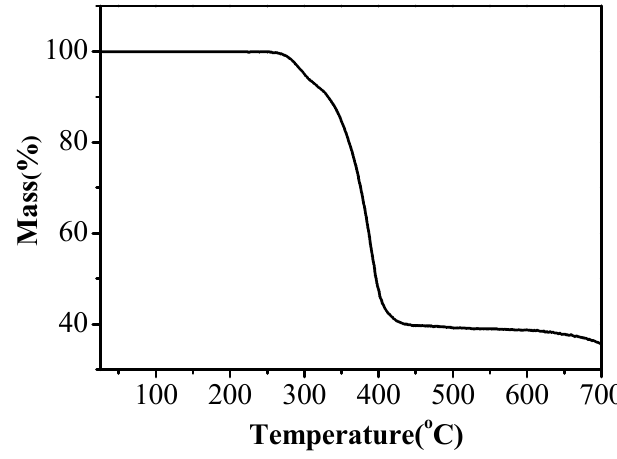
Figure 2. Thermogravimetry (TG) curve of the polymer.